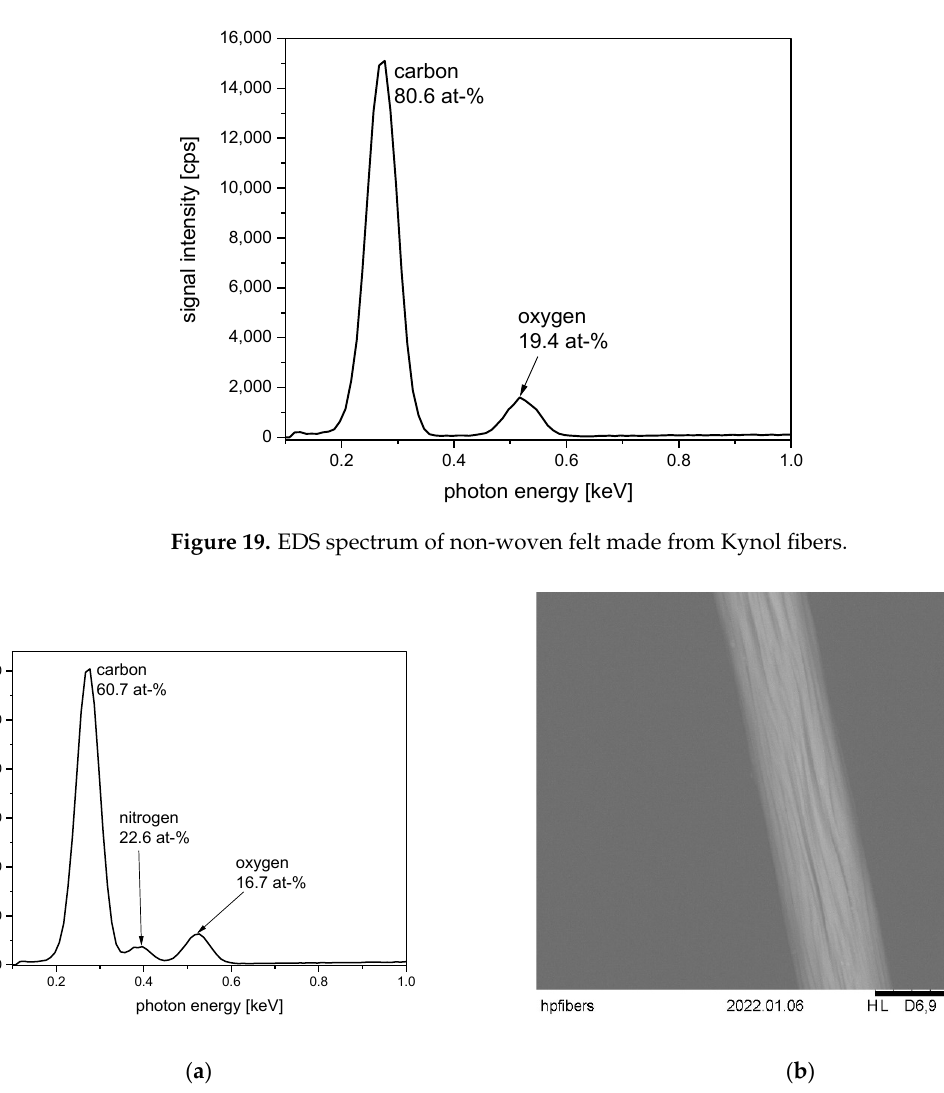
Figure 18. EDS spectra of different flame-retardant polyimide PI fiber materials: ( a ) PI fiber material P84 from Evonik; ( b ) polyimide material taken from a non-woven filter material. The EDS spectrum of a Kynol fiber material exhibits signals for the two elements carbon and oxygen (Figure 19). A high carbon content of more than 80 at-% is determined,